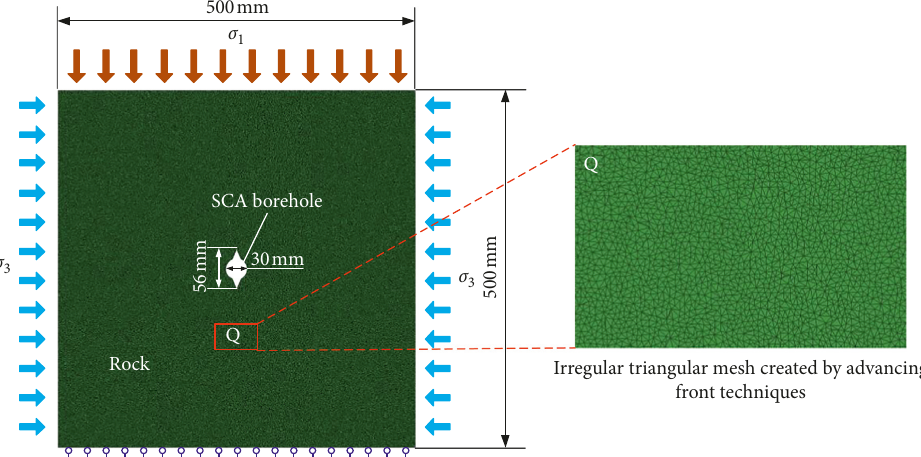
Figure 11: The mesh model.